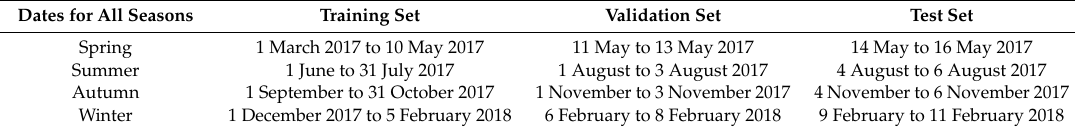
Table 1. Dates for LSTM (long-short term memory) forecasting models in all seasons. Dates for All Seasons Training Set